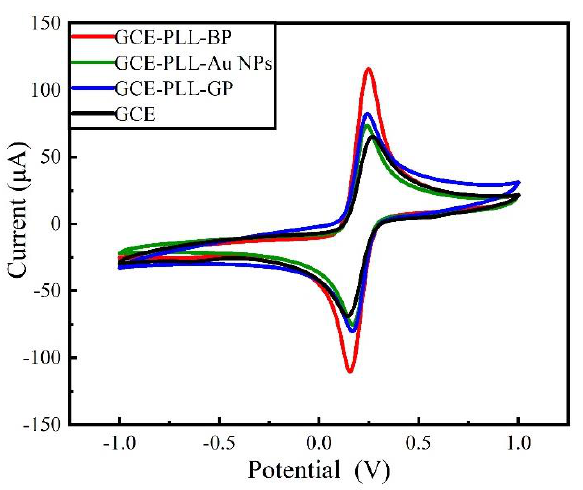
Figure 3. CV diagram of polylysine modified GCE electrode with black phosphorus nanosheets, graphene and gold nanoparticles in K 3 [Fe (CN) 6 ] hybrid system.